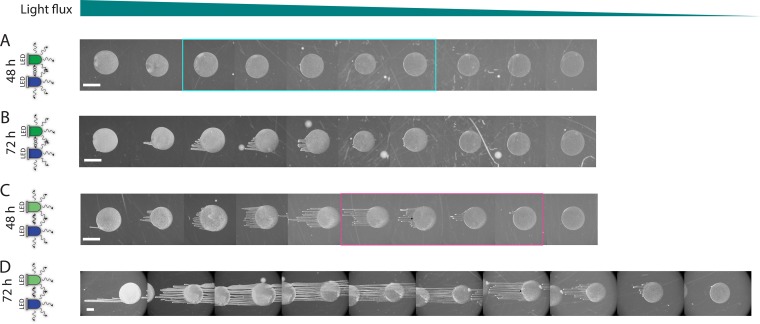
Multiple signals with different wavelengths prompt a complex range of behaviors that integrate promotion and inhibition of phototaxis with cellular proliferation. (A and B) Synechocystis communities were exposed to a combination of the low-intensity green LED used in Fig. 4A and the blue LED used in Fig. 4C. (A) After 48 h, phototaxis was almost completely inhibited, although the droplets highlighted in cyan exhibited a peripheral halo of cells in the direction of the LEDs. (B) After 72 h, a small degree of phototaxis was evident at intermediate intensities. (C and D) Communities were exposed to a combination of the high-intensity green LED used in Fig. 4B and the blue LED used in Fig. 4C. After 48 h (C), at all intensities, the brightness of the communities indicated that cells underwent more proliferation than in the presence of either green or blue light alone. At the higher intensities of blue and green light, phototaxis was inhibited relative to green LED illumination alone. At moderate intensities (highlighted in the pink box), phototaxis was intensity dependent and communities exhibited more movement toward the light than under green light alone. This pattern of phototaxis was still present after 72 h (D). Bar, 2 mm (all panels). Similar behavior was observed in 7 experiments.